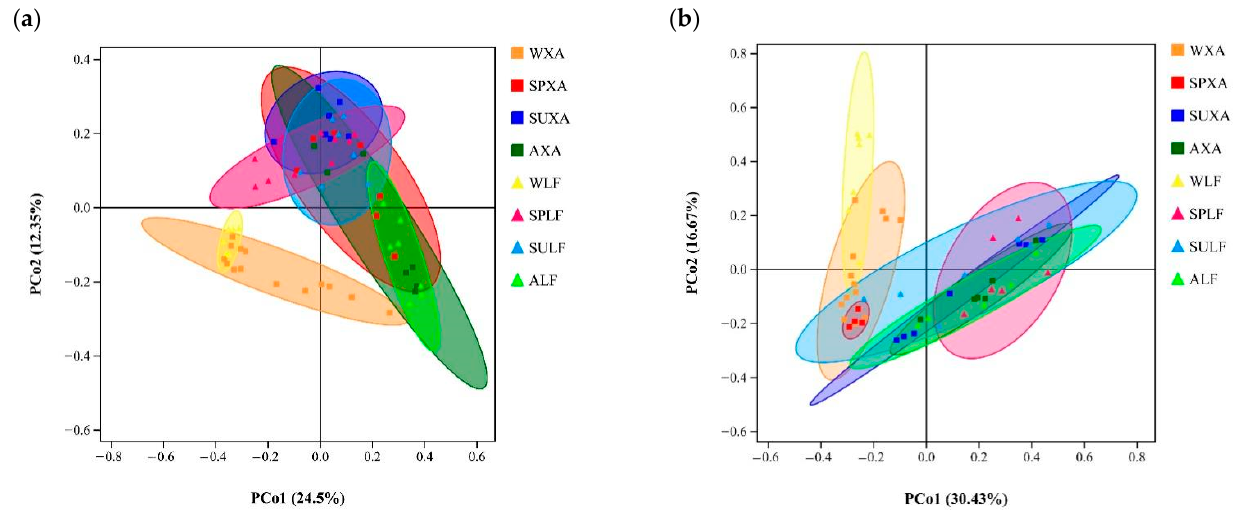
Figure 2. Comparing the bacterial ( a ) and fungal ( b ) communities in Xi’an and Linfen in the four seasons using PCoA at the OTU level. Samples of Xi’an and Linfen are represented by squares and triangles, respectively. Color ellipses (winter, yellow; spring, red; summer, blue; autumn, green) based on 95% confidence interval demonstrate seasonal changes of microbial communities.